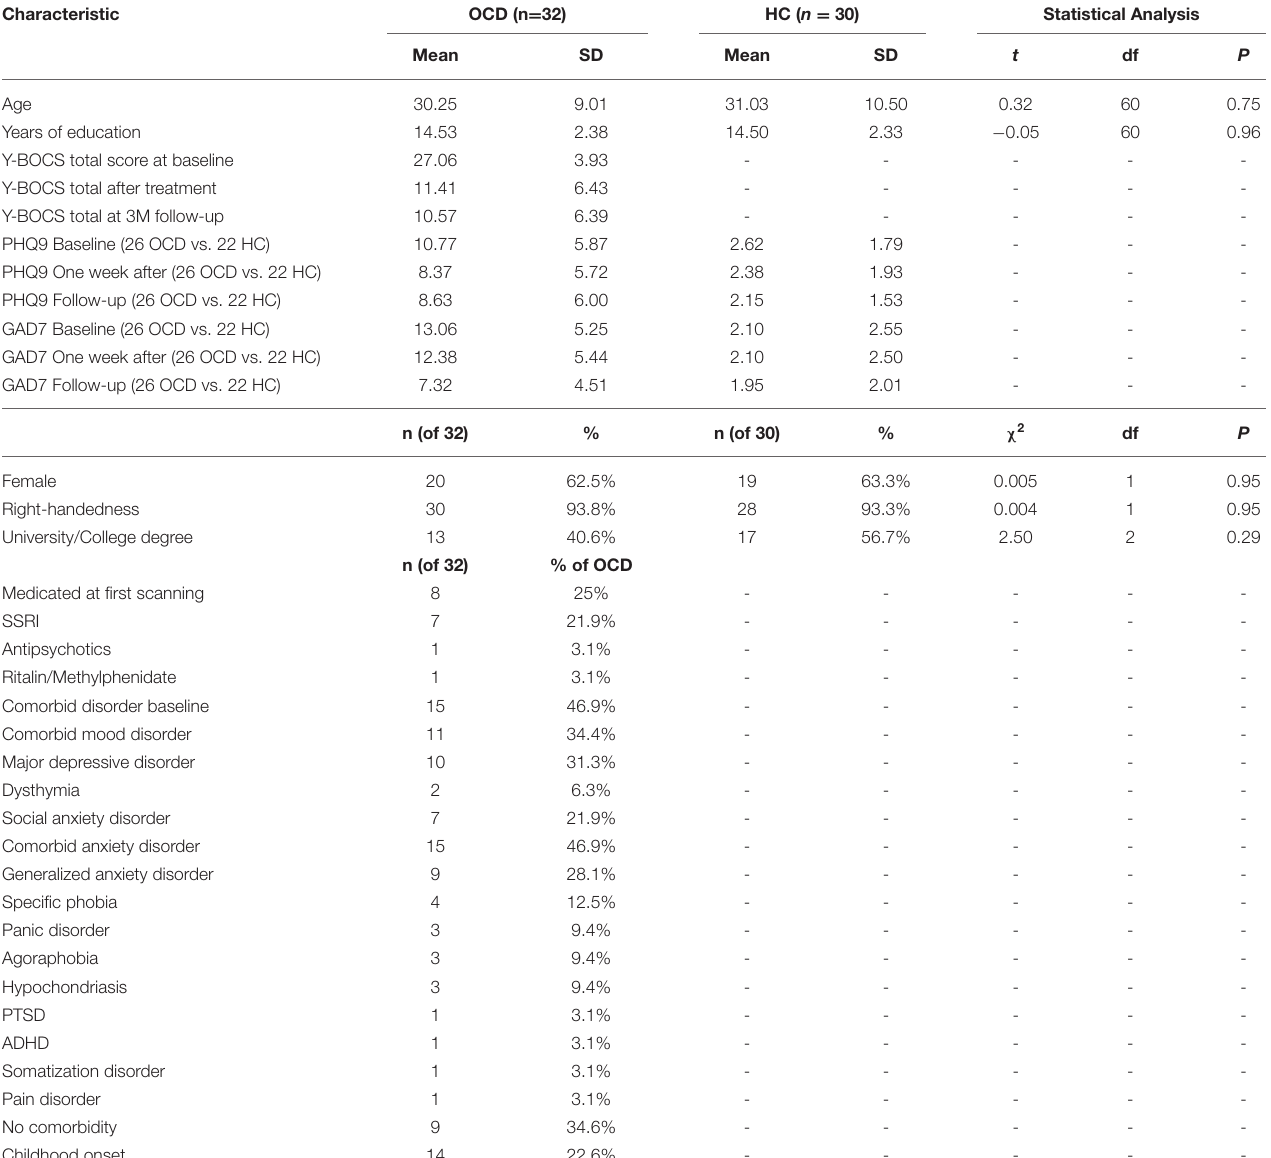
TABLE 1 | Demographics and clinical characteristics in the